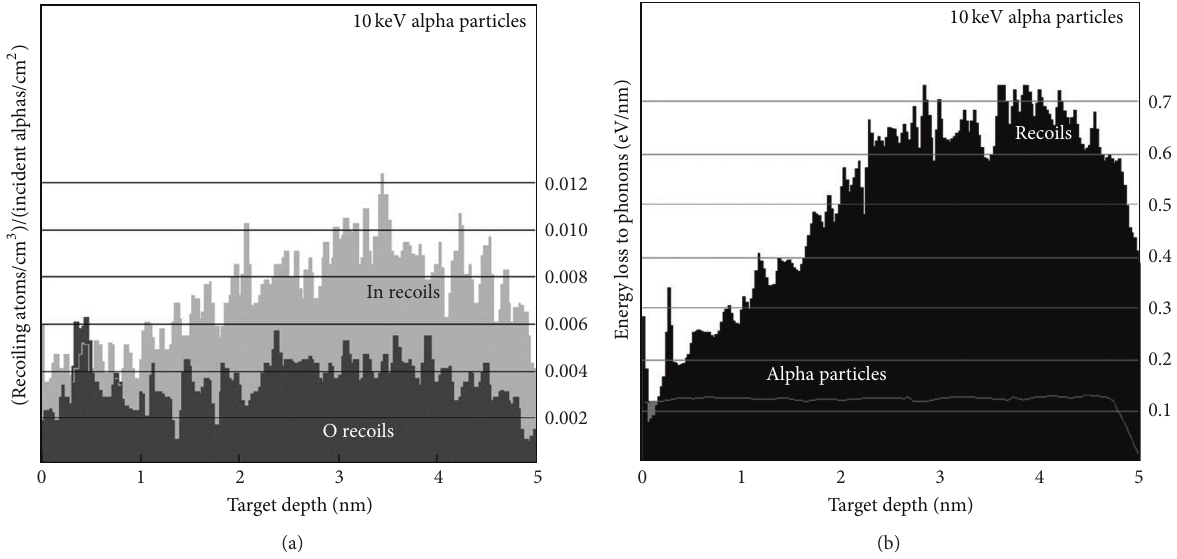
Figure2:Resultsofirradiatinga5nmthickInO 𝑥 filmbyabeamof10 4 alphaparticleswith10 keVenergy.(a)Distributionoftheconcentration of the displaced indium and oxygen atoms (recoils) per unit alpha particle fluence. (b) Energy loss to phononic excitations per unit depth by alphas and